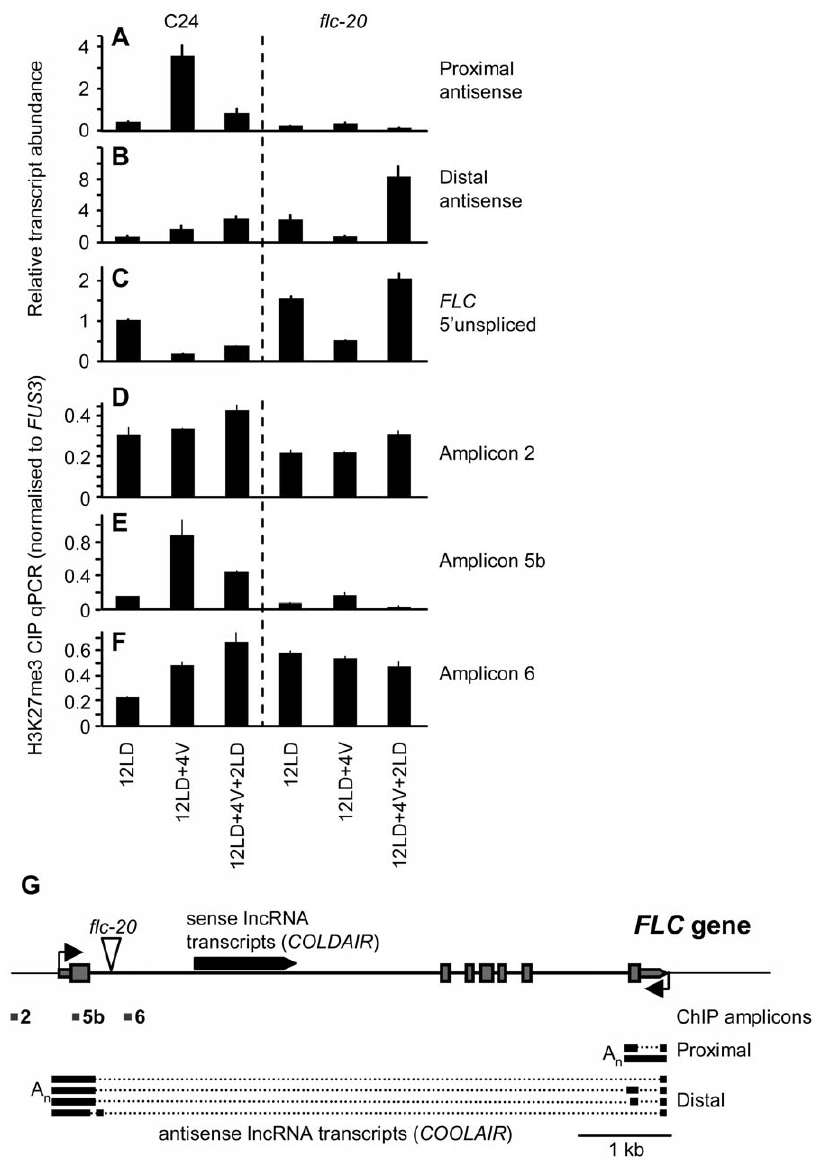
Figure 1. FLC is transiently repressed by extended cold in the flc-20 mutant. A, B and C) qPCR quantification of proximal antisense (A), distal antisense (B) [28], and FLC 5 9 unspliced transcript (C) is shown for C24 and flc-20 for plants grown for 12 long days in warm conditions (12LD), 12 days in warm and transferred to cold conditions for 4 weeks (12LD + 4V) or cold treated then returned to warm conditions for 2 days (12LD + 4V + 2LD). D, E and F) H3K27me3 ChIP-qPCR for amplicon 2 (D), amplicon 5b (E) and amplicon 6 (F) in C24 and flc-20 , on same plant samples used in A–C. G) Diagram of the FLC gene and associated lncRNAs. Exons of the sense transcript are shown boxed, the exons of mature antisense transcripts [16] are shown in bold, introns in antisense transcripts are shown as dotted lines. Transcription starts indicated by arrows, triangle marks Ds insertion in flc-20 . The Ds inserted in intron 1 of FLC in flc-20 contains a GUS reporter gene and nptII resistance gene [21]. It is likely that the transcript detected with the distal primers in flc-20 originates from within the Ds insertion as no PCR product is obtained using a primer set that spans the large intron in the distal antisense transcripts [18]. doi:10.1371/journal.pone.0021513.g001 separates these regions in the endogenous FLC gene [21]. Using of antisense transcripts in these lines showed that transcription the abundance of FLC 5 9 unspliced transcript as an approximation from the COOLAIR promoter was greatly reduced in flc-20 and of transcription rate [18] we showed that vernalization leads to a was only weakly induced during the cold compared to the C24 reduction of transcription in the flc-20 mutant that was not control ( Figures 1B and 1C ). An antisense transcript was maintained after plants were returned to warm conditions detected 5 9 of the Ds insertion in flc-20 that we speculate originates ( Figure 1A ). The results of physically separating the FLC from within the Ds element; in contrast to the situation in C24 this promoter and first intron thus mirror those for reporter constructs transcript was repressed by cold. There is an increase of showing that the intron and promoter together are required for the H3K27me3 across the first exon of FLC (amplicon 5b) in both stable repression of FLC expression by vernalization. Examination C24 and flc-20 at the end of cold, but this increase is not